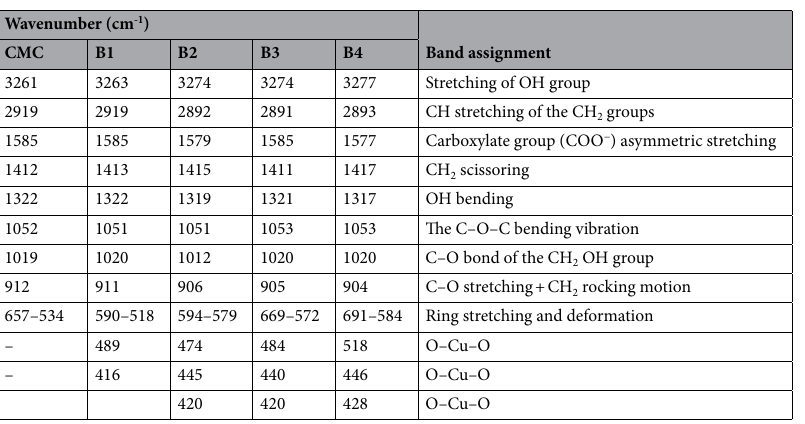
Table 3. FTIR band assignments for pure CMC and CMC filled with different concentrations of CuO-NPs.